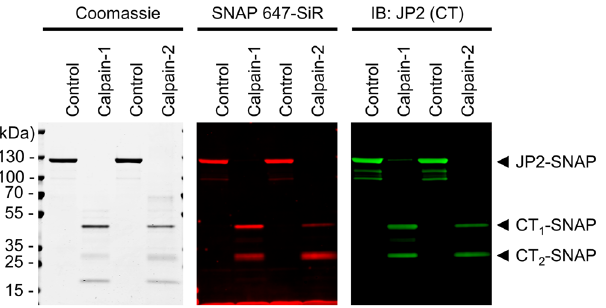
Figure 3. Identification of two unique C-terminal mouse FL JP2 cleavage fragments by SNAP-tagging and in-gel flourescent product detection. Recombinantly expressed, puried C-terminally SNAP-tagged JP2 was labeled with the high-affinity SNAP ligand 647-SiR and digested with 1.0 U/ml Calpain-1 or 1.0 U/ml Calpain-2 for 30 min at 30 °C. Digested samples were subjected to SDS-PAGE, Coomassie staining, in-gel 647-SiR flourescence detection, and immunoblotting as indicated. Two unique C-terminal fragments were identified by 647-SiR in-gel fluorescence, and each confirmed by Coomassie staining and immunoblotting, namely 647-SiR- tagged CT 1 and CT 2